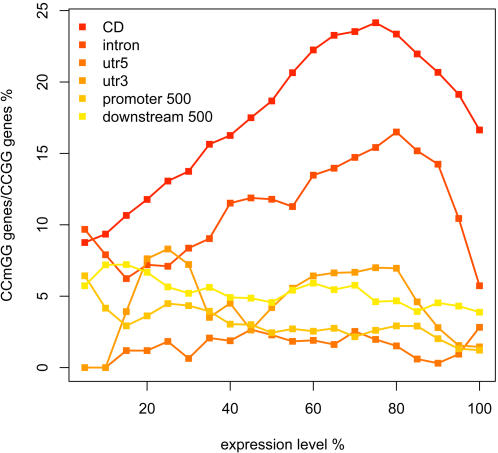
Correlation between Constitutive CG Methylation and Absolute Gene Expression Level.Genes possessing CCGG-containing feature(s) within analyzed sequence category were divided to 20 percentiles based on absolute gene expression level. Within each expression percentile (x-axis), percent genes with constitutive CG methylation site(s) was plotted as y-axis. The analyzed annotation categories were: coding sequences (CD); 5′ UTRs (utr5); 3′ UTRs (utr3); sequences from transcriptional start to upstream 500 bp (promoter 500); sequences from transcriptional stop to downstream 500 bp (downstream 500).